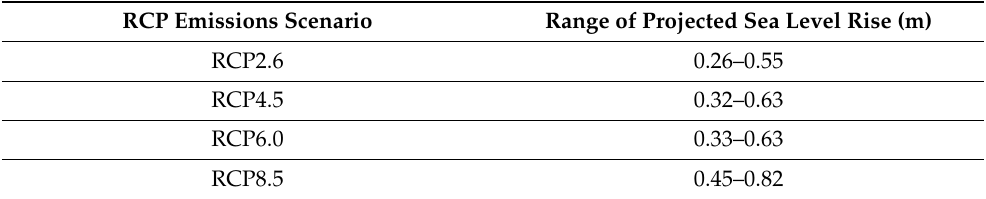
Table 1. Global mean sea level rise projections for 2100, under varying emissions scenarios